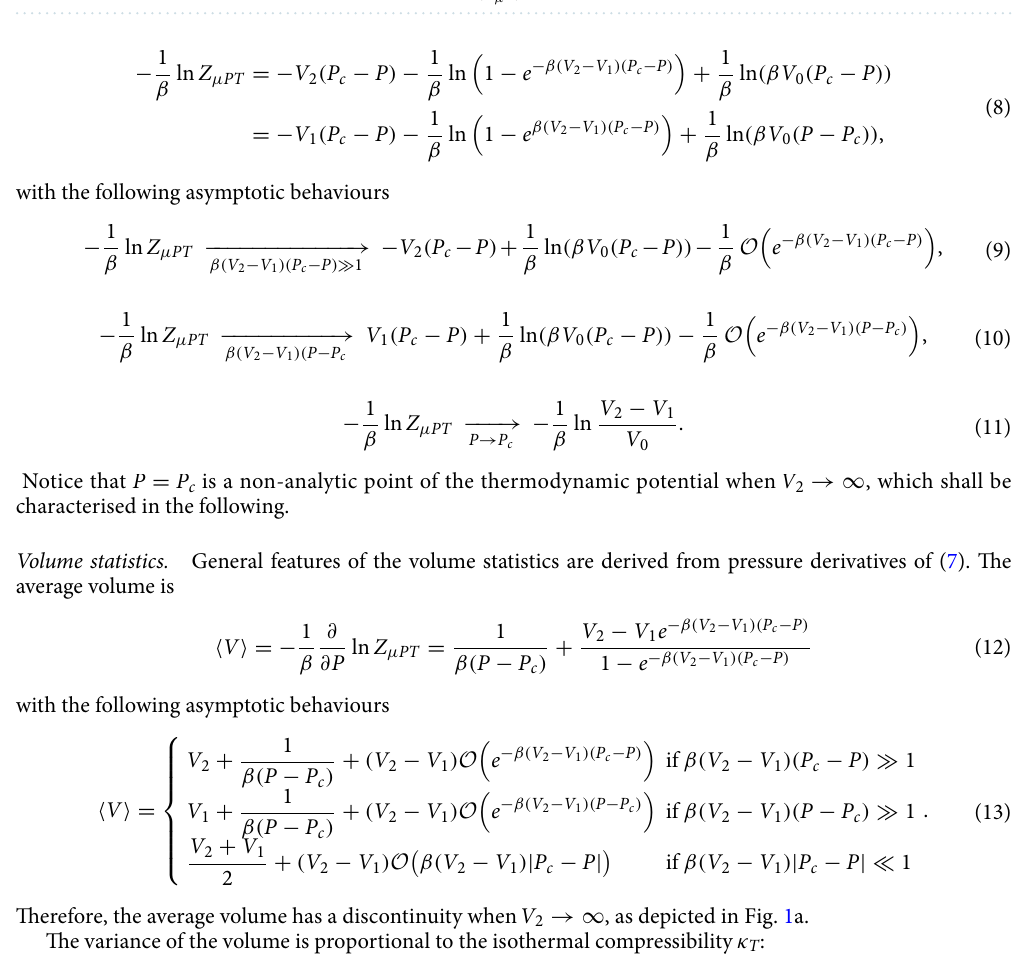
2 ρ P c as a function of the rescaled pressure P c ∂ 2 µ 2 ρ P c P c ∂ 2 µ